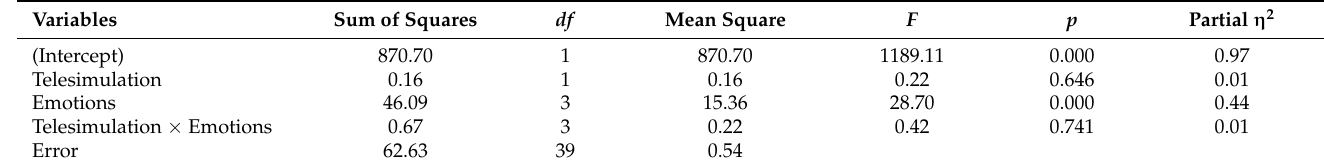
Table 2. ANOVA results of emotions before the